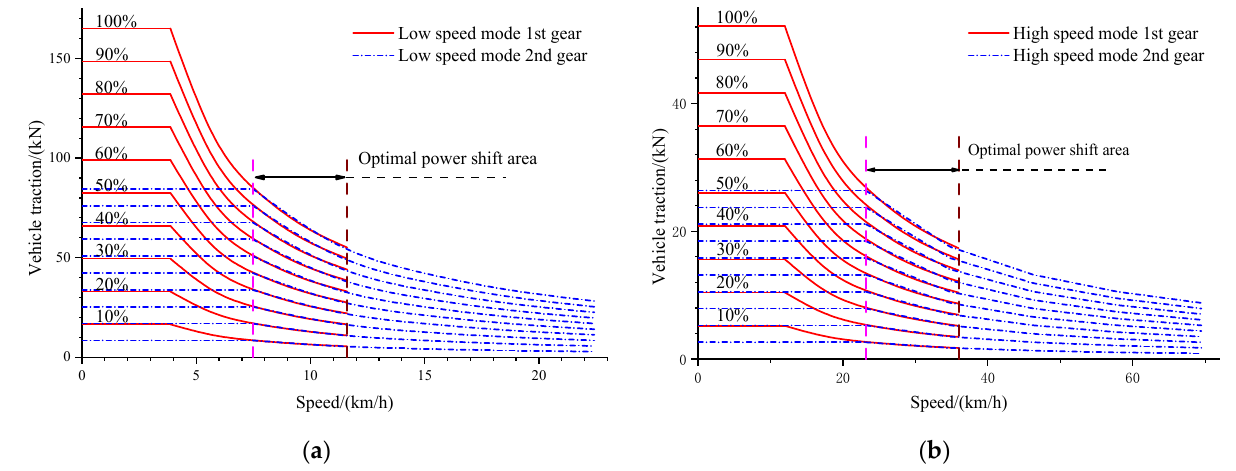
Figure 4. The driving force characteristic curve of the whole machine under different gears. ( a ) Low- speed mode; ( b ) High-speed mode. (3) According to the analysis above, in the optimal power shift area, two straight per- pendicular lines are arbitrarily selected for the speed axis. The intersection of the straight line and the traction curve of the whole machine are connected. The best dynamic curve can then be obtained. In addition, when formulating the downshift rule, in order to avoid cyclic shift, the downshift curve is usually reduced by 2~8 km/h on the basis of the upshift curve. Due to the low overall speed of construction machinery, the downshift curve in low-speed mode is taken to reduce 2 km/h com- pared to the upshift curve, and then 3 km/h in high-speed mode. As a result, the optimal power rule curve can then be obtained, as seen in Figure 5.